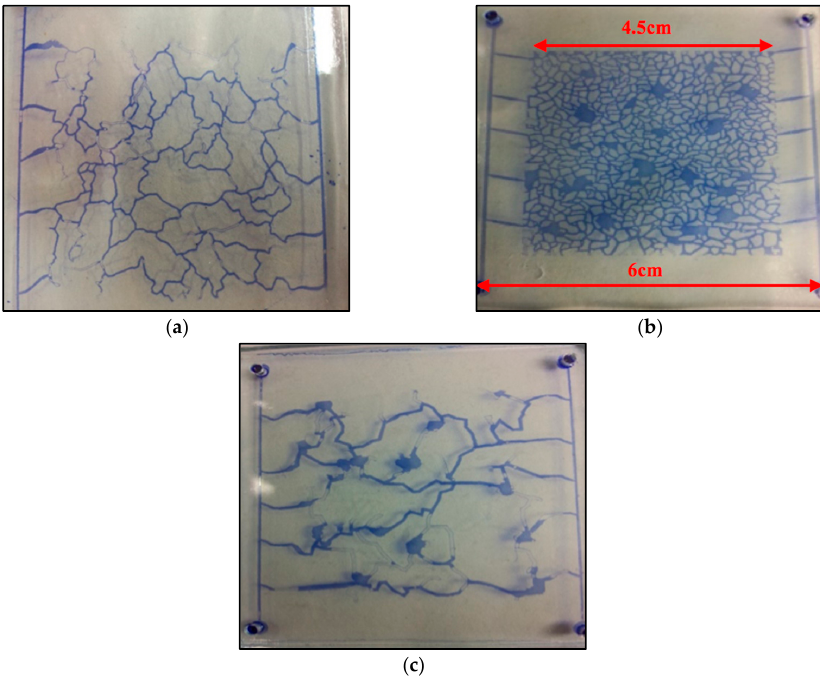
Figure 6. Fabricated visual micromodels based on the microelectronic photolithography technique: ( a ) Fracture-type; ( b ) Cavity-type; ( c ) Fracture–cavity-type.